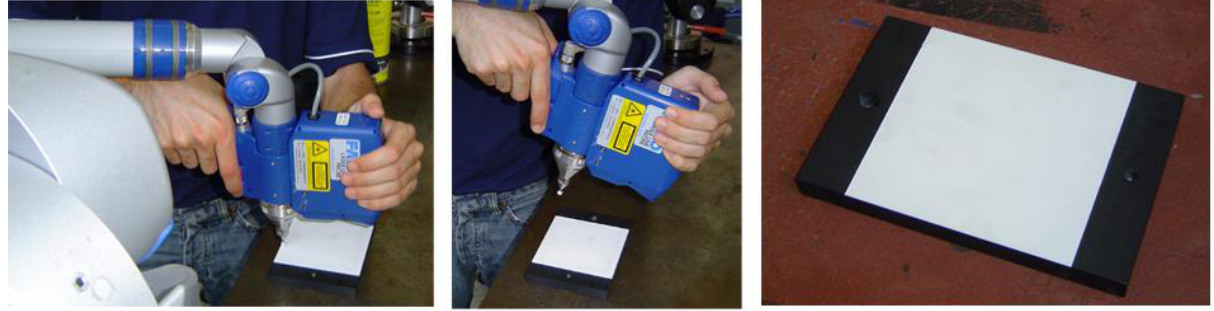
Figure 1. Contact and non contact measurement of a gauge plane to obtain an estimation of position and orientation of LTS coordinate system in AACMM last frame by